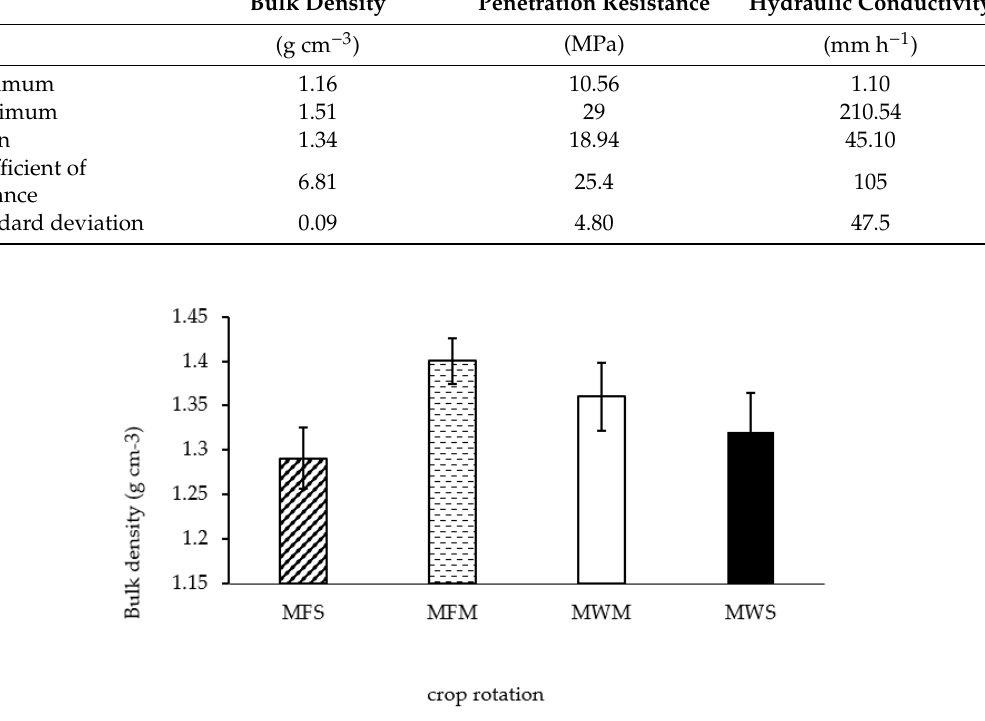
Figure 1. Effects of crop rotation on bulk density after 3 years of cropping. MFM is maize-fallow-maize; MWM is maize-wheat-maize; MWS is maize-wheat-soybean; MFS is maize-fallow-soybean. Error bars indicate standard deviation.